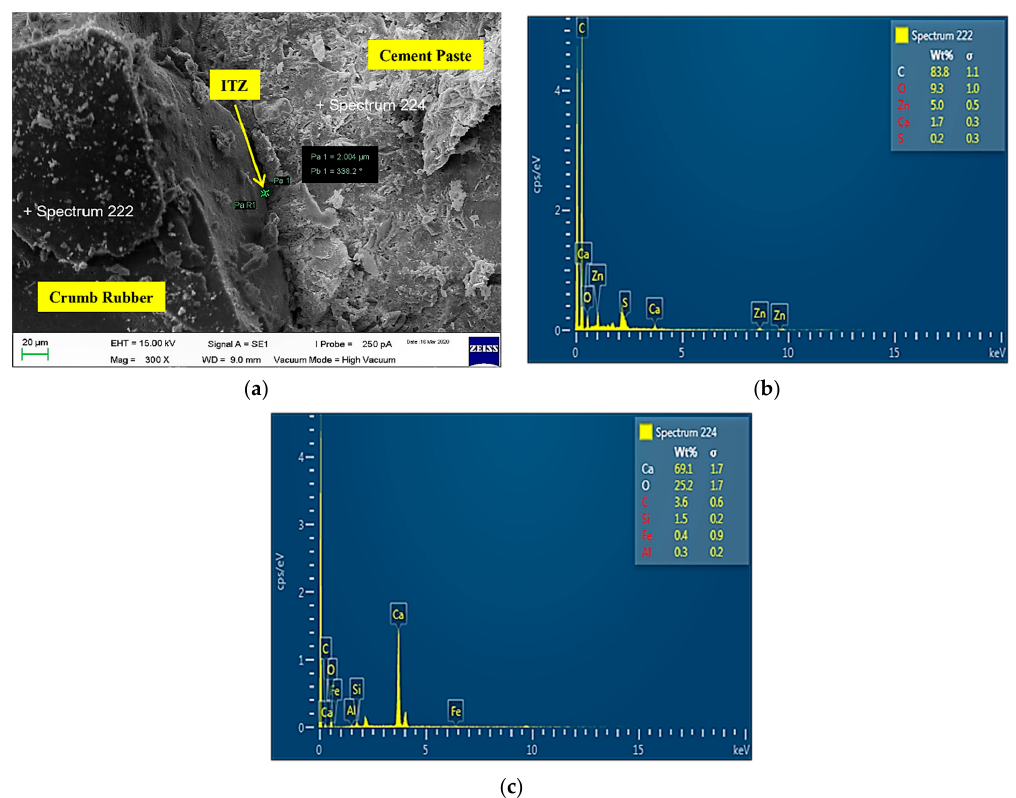
Figure 17. CR7.5-NS2.5 sample. ( a ) Microstructure ITZ = 2.004 μ m; ( b ) EDX of crumb rubber; ( c ) EDX of cement.